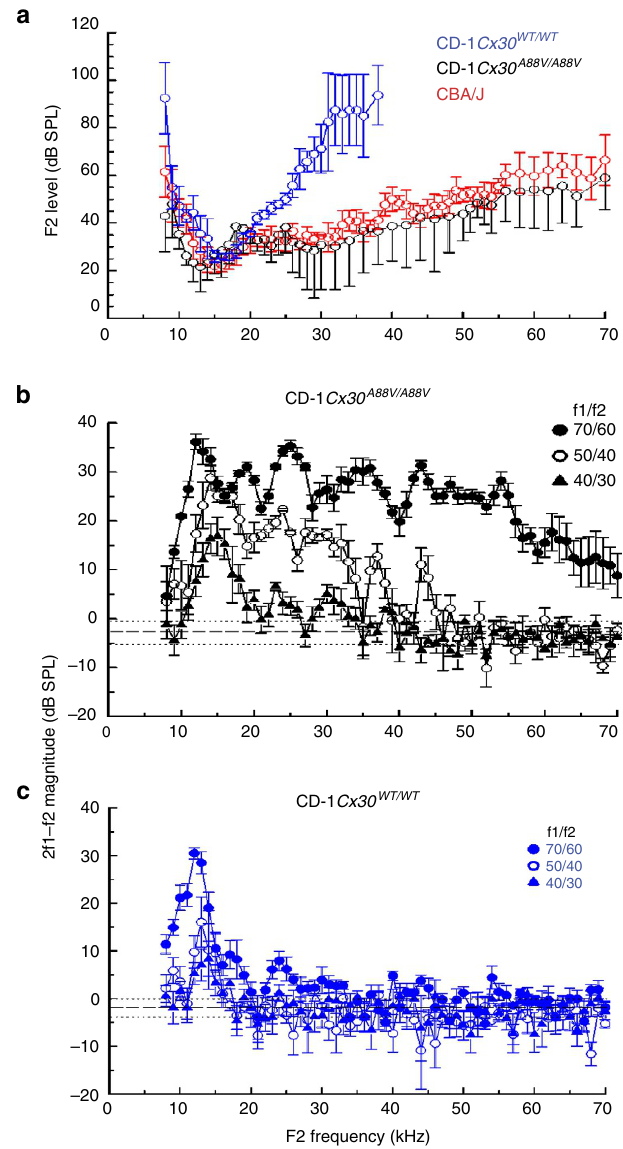
Figure 2 | DPOAE audiograms. ( a ) DPOAE threshold (2f1–f2, 0dB SPL threshold criterion, mean ± s.d.) as a function of the f2 frequency (f2/f1 ratio ¼ 1.23; level of f2 set 10dB below f1 level) from six CD-1 Cx30 WT/WT (blue symbols) and five CD-1 Cx30 A88V/A88V (black symbols) mice, and from seven CBA/J mice (red symbols). The maximum SPL of the sound system was restricted to r 110dB for frequencies Z 35kHz. ( b , c ) DPOAE magnitude (2f1–f2, mean ± s.d.) as a function of the f2 frequency for five CD-1 Cx30 A88V/A88V mice ( b ) and five CD-1 Cx30 WT/WT mice ( c ). Stimulus levels and colour and symbol coding for f1 and f2 are shown in the figures. X axis: f2 frequency (kHz) for all figures. Dashed and dotted lines indicate the recording noise floor ± s.d. for all